Question: Which visualization type does this figure use?
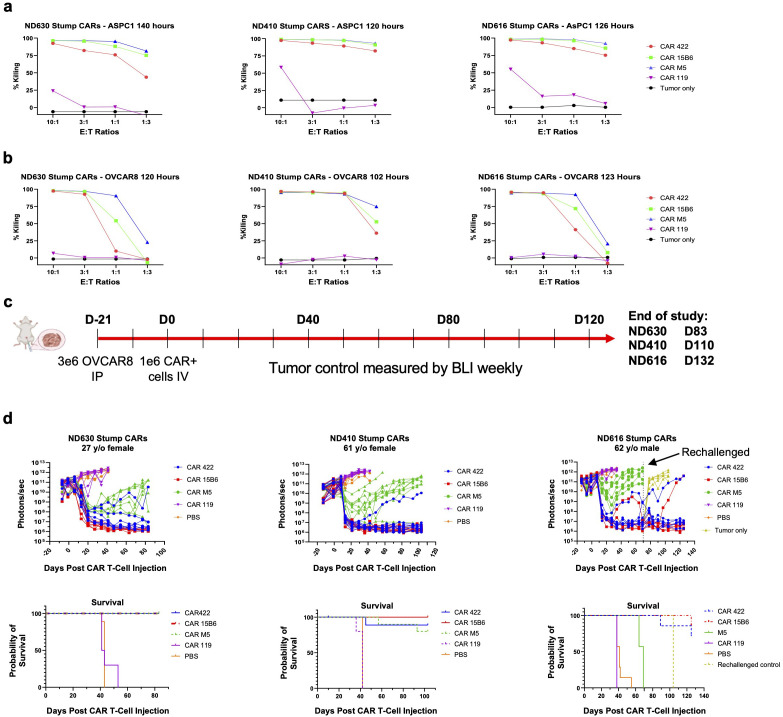
Answer: survival